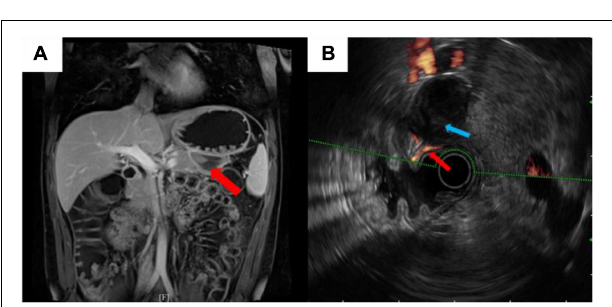
FIGURE 2 | (A) Enhanced magnetic resonance imaging (MRI) revealed no sign of space-occupying lesion. Red arrow showed a hematoma in the gastro-pancreatic gap. (B) Endoscopic ultrasonography (EUS) illustrated the vascular malformation in the muscularis of the stomach. Blue arrow showed a hypoechoic shadow. Red arrow showed a 1.3-mm diameter blood flow signal was continuous between the muscularis propria and the hypoechoic